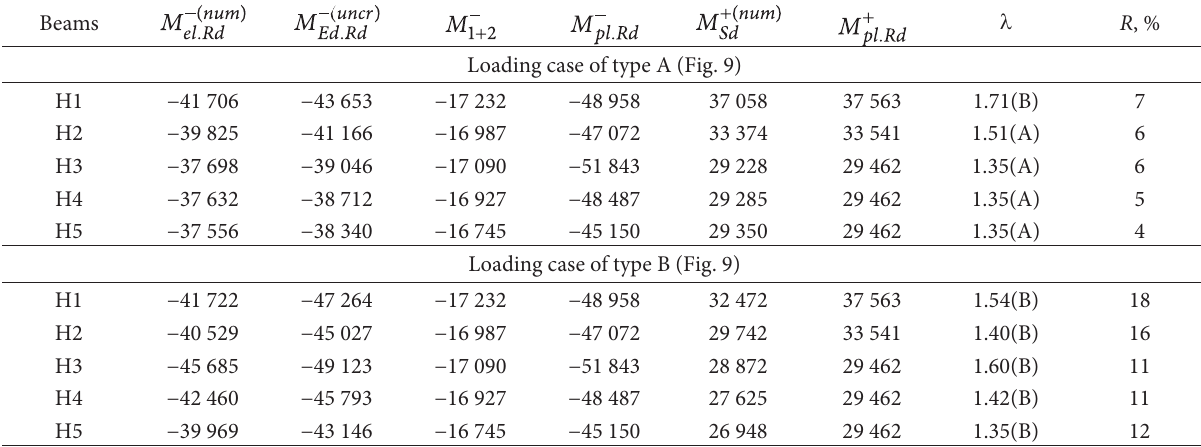
Table 5. Hogging and sagging bending, kNm – see Table 3 (class 3) ‒ all options – local buckling not included Beams λ Loading case of type A (Fig. 9)